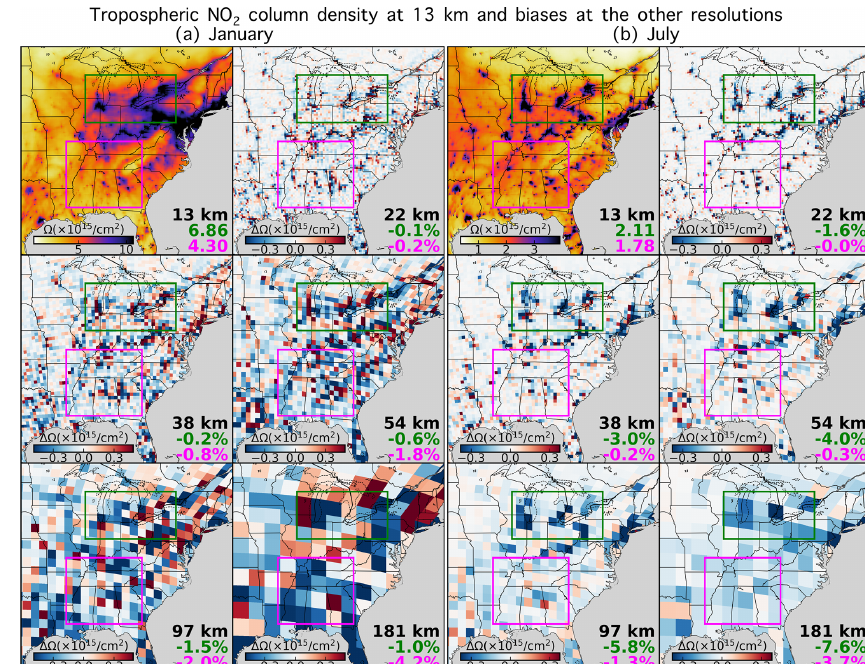
Figure 7. Coarse-resolution simulations yield positive biases in spaceborne inverse modeling of NO x emissions. Panels (a) and (b) are both similar to Fig. 1c (for January and July 2015, respectively) but for the mean GEOS-Chem tropospheric NO 2 column density (in molec.cm − 2 ) during afternoon satellite overpass time